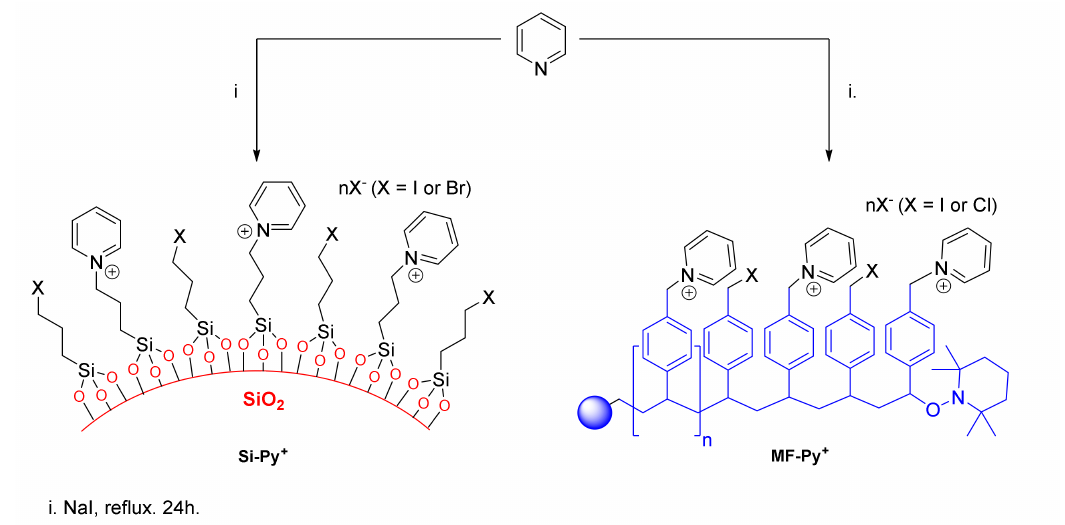
Scheme 2. Cationization of the materials Si and MF with